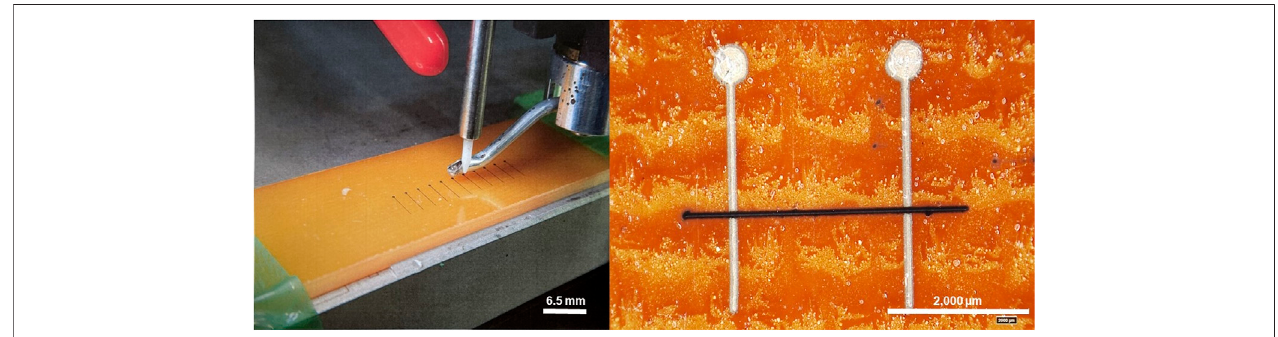
FIGURE 1 | Left: Aerosol deposition ofink on FR4 substrate for conductivity measurements. Right: Conductive trace of CNT based ink (black) between two silver- based electrodes (light-grey), both produced via aerosol deposition.